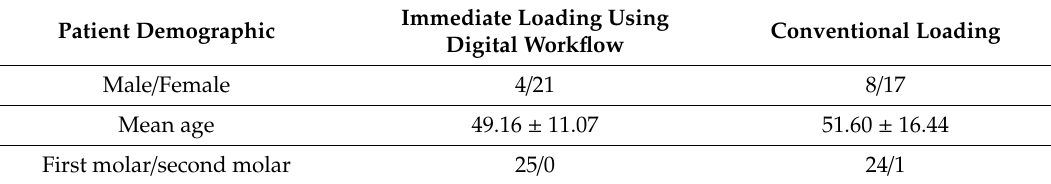
Table 3. Patient Demographics.